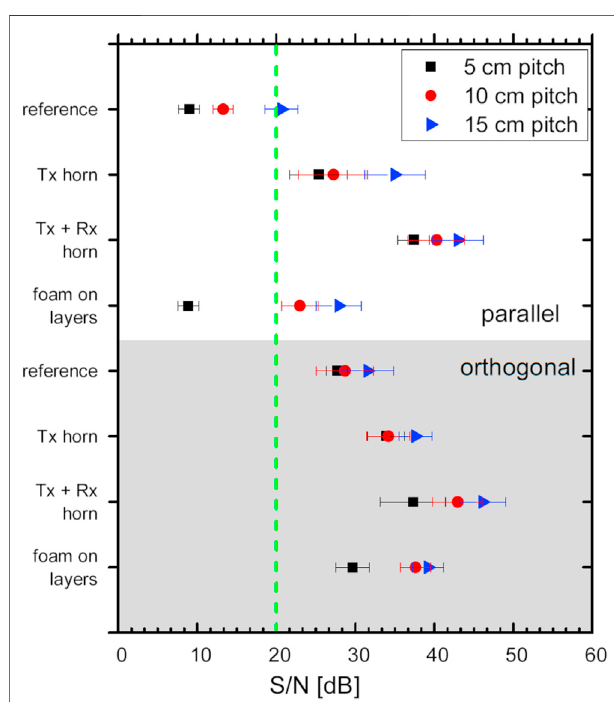
FIGURE 9 | S/N for two parallel links operated between two fully re fl ective aluminium layers at a distance of 10 cm. Results are shown for parallel polarization states (top, white background) and orthogonal polarization states (bottom, grey background) [26].